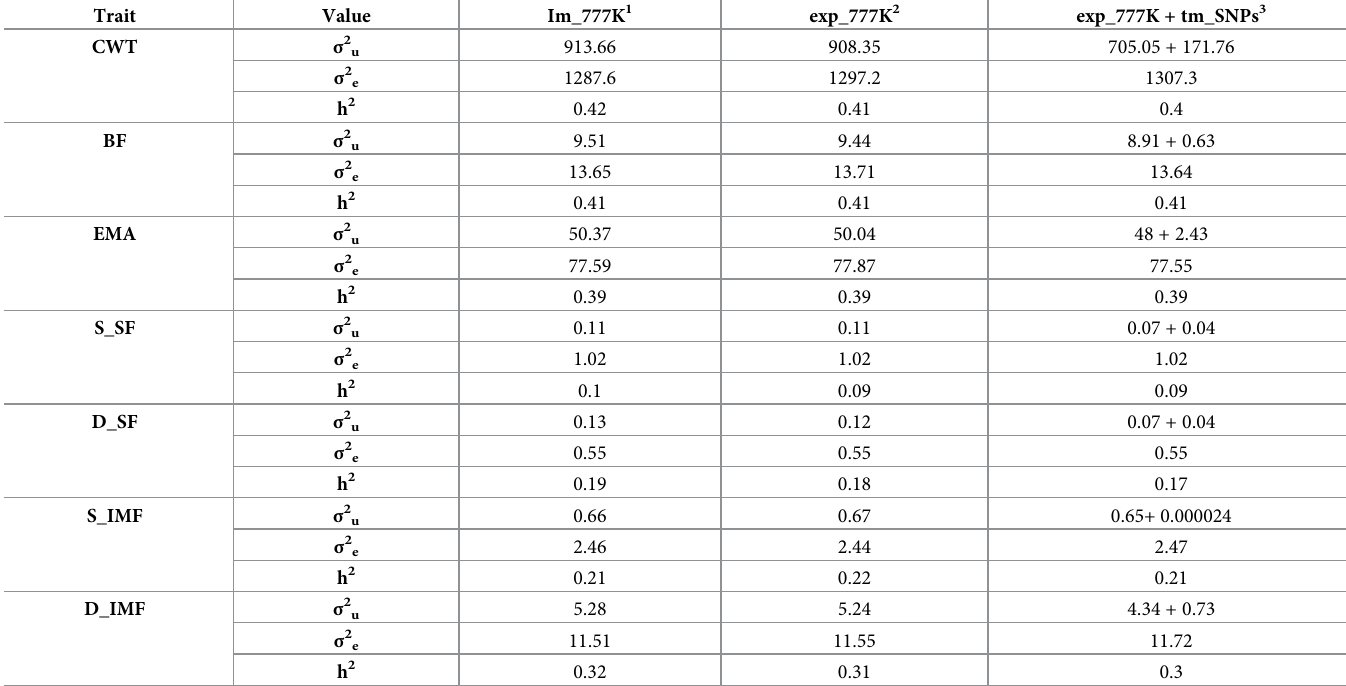
Table 4. Variance components at different marker set.